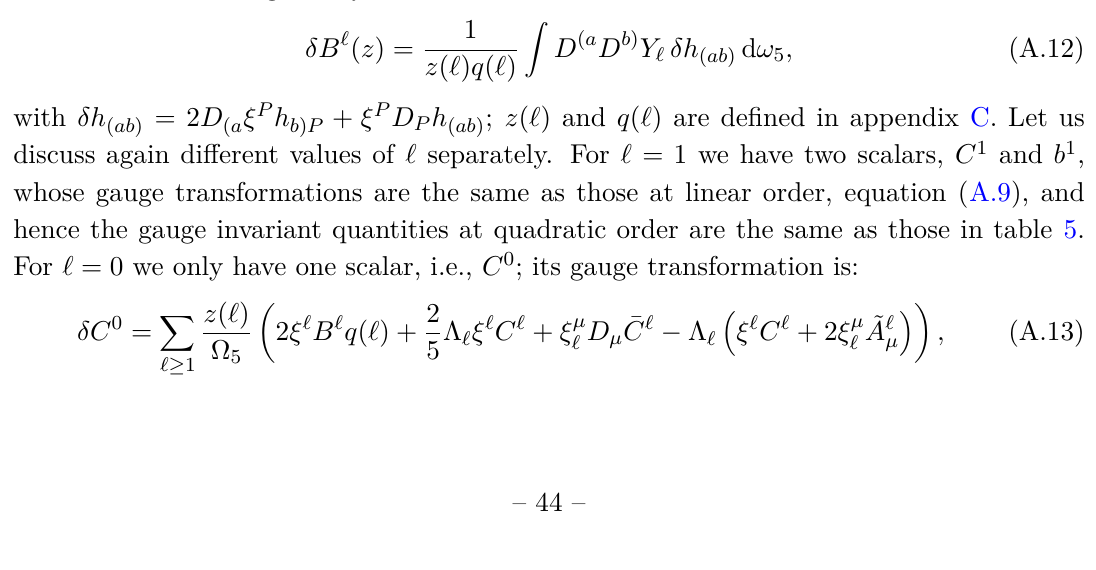
˜ = ξ 1 , and for ‘ > 1 , A 1 µ µ